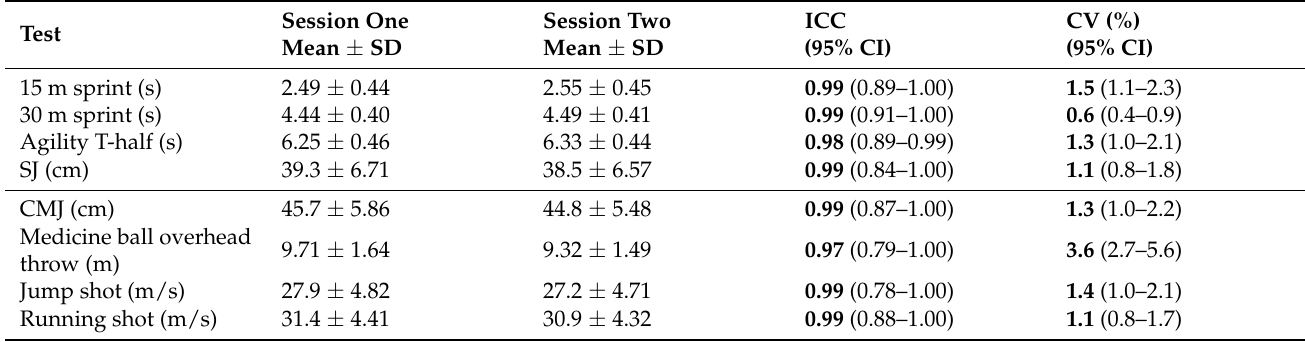
Table 1. Comparison of the test measurements obtained from the two testing sessions prior to the intervention ( N = 25). The descriptive statistics (mean ± SD) and intrarater reliability analysis that were calculated for each test are presented. ICC ≥ 0.75 and CV ≤ 10% are marked in bold. SJ: squat jump, CMJ: countermovement